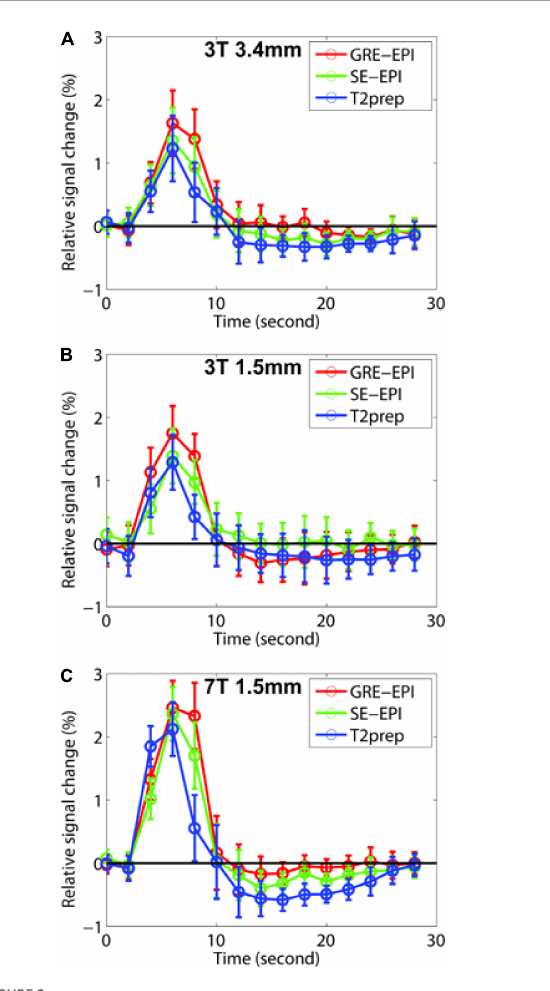
FIGURE2 The fitted hemodynamic response functions (HRF) averaged across all participants ( n = 10) from gradient-echo (GRE) echo-planar-imaging (EPI) (red), spin-echo (SE) EPI (green), and T2-prepared (T2prep) blood oxygenation level dependent (BOLD) functional MRI (fMRI) (blue) on 3T and 7T are shown. Results from 3T with 3.4 × 3.4 × 4 mm 3 voxel, 3T with 1.5 mm isotropic voxel, and 7T with 1.5 mm isotropic voxel are shown in (A–C) , respectively. The error bars indicate inter-subject standard